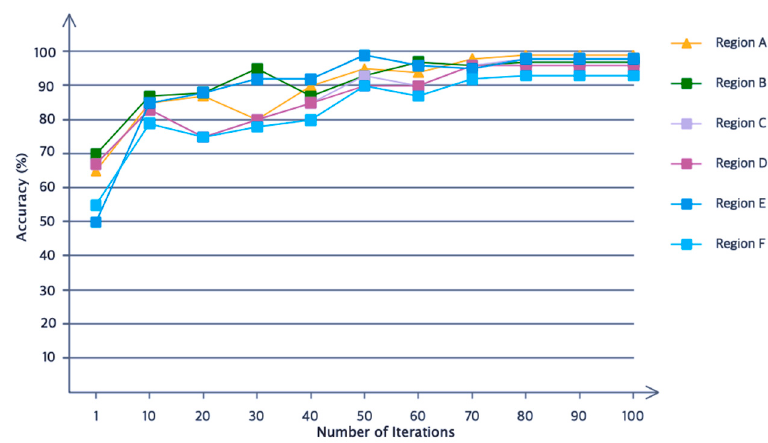
Figure 9. The proposed network accuracy for all regions for validation data.